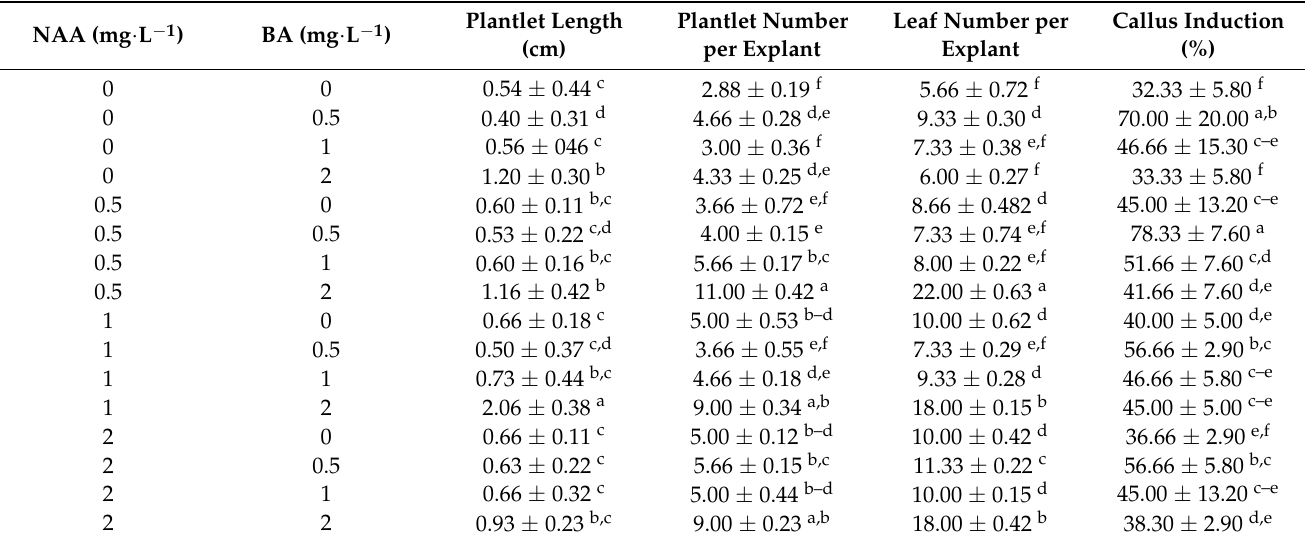
Table 1. Effect of different concentrations of NAA and BA on the measured characteristics of Zamioculcas zamiifolia (Lodd.) Engl. ‘Dowon’ grown in vitro in the multiplication